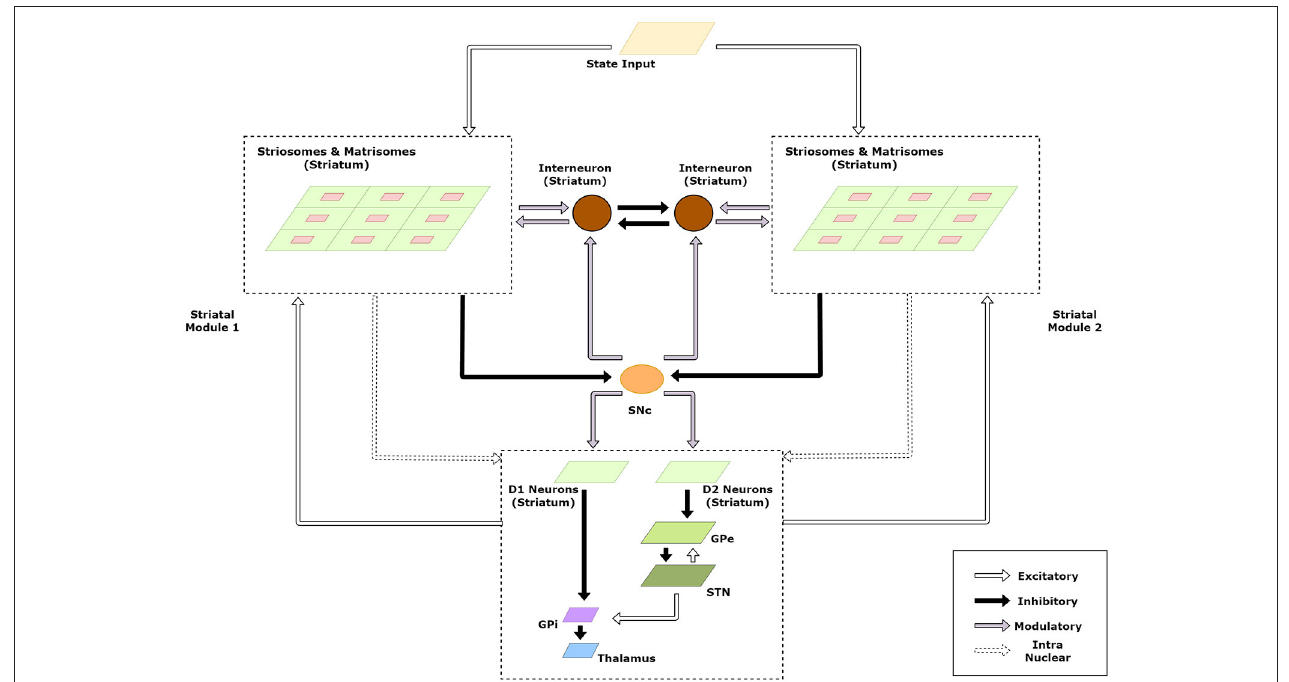
FIGURE 3 | Schematic of the extended model to handle modular RL tasks showing the case with two striatal modules. The state representations of the two modules are used to calculate their respective responsibilities which are then used by the striatal interneurons to choose the appropriate module.